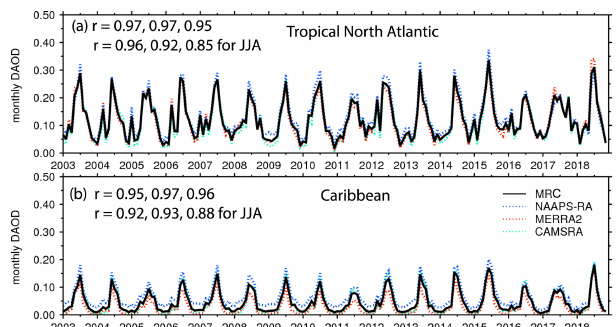
Figure 4. Monthly DAOD at 550nm from CAMSRA, MERRA- 2, NAAPS-RA, and MRC from 2003 to 2018 for the (a) tropical North Atlantic and the (b) Caribbean. Correlations between CAM- SRA and MERRA-2, CAMSRA and NAAPS-RA, and MERRA-2 and NAAPS-RA are displayed in sequence for all months and for JJA-only respectively.